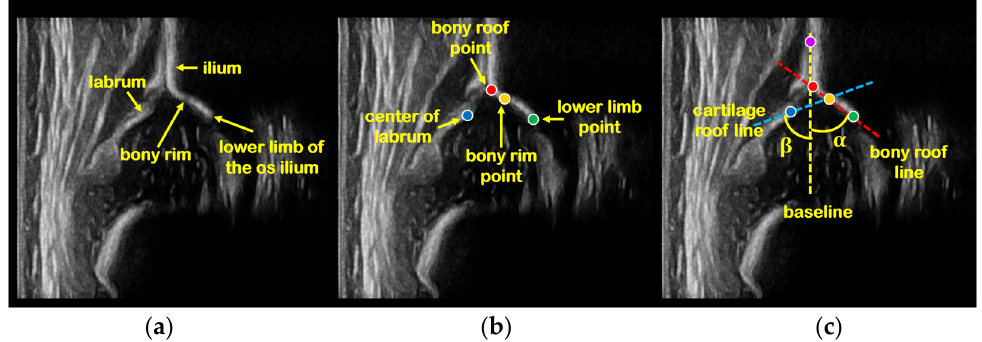
Figure 1. Example of a hip joint US image and Graf’s method. ( a ) The anatomical structures in stand- ard plane. ( b ) Four landmarks determined based on the anatomical structures, bony roof point (red dot), bony rim point (yellow dot), lower limb point (green dot), and the center of labrum (blue dot). ( c ) Measurement lines and α , β angles. First, the uppermost point of the cartilaginous roof (purple dot) must be sought. From this pivot at the uppermost point of the cartilaginous roof, the baseline (yellow dash line) is a tangent placed cranial to caudal along the echo of the ilium. The lower limb of the os ilium (green dot) is the pivot point, and the bony roof line (red dash line) is a tangent placed laterally from the pivot point just touching the bony roof (red dot). The cartilage roof line (blue dash line) is drawn from the bony rim (yellow dot) through the center of the labrum (blue dot). α is the angle between bony roof line and baseline, and β is the angle between cartilage roof line and base- line.